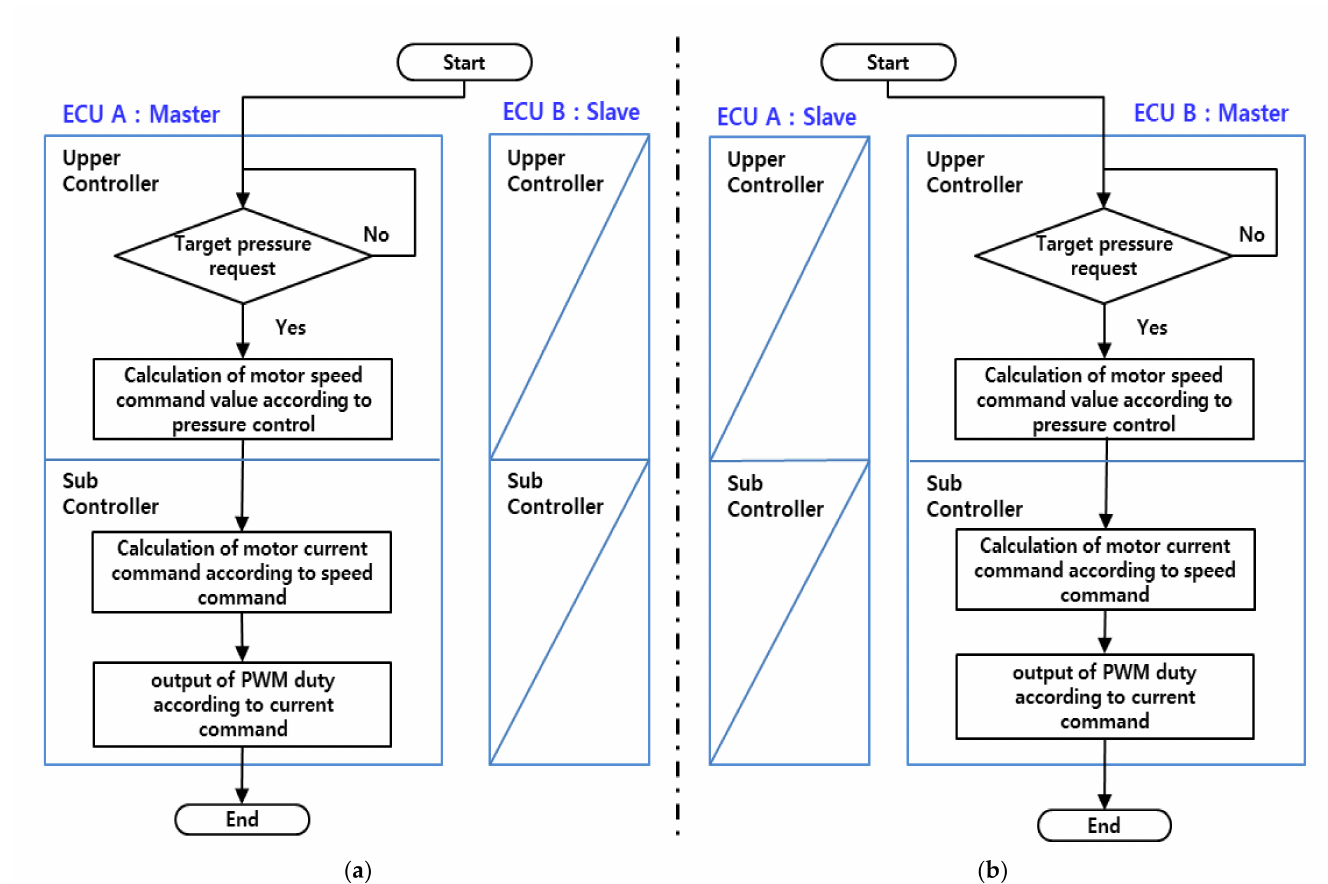
Figure 9. Flowchart of the proposed current control method in the normal state: ( a ) single fault in ECU B; ( b ) single fault in ECU